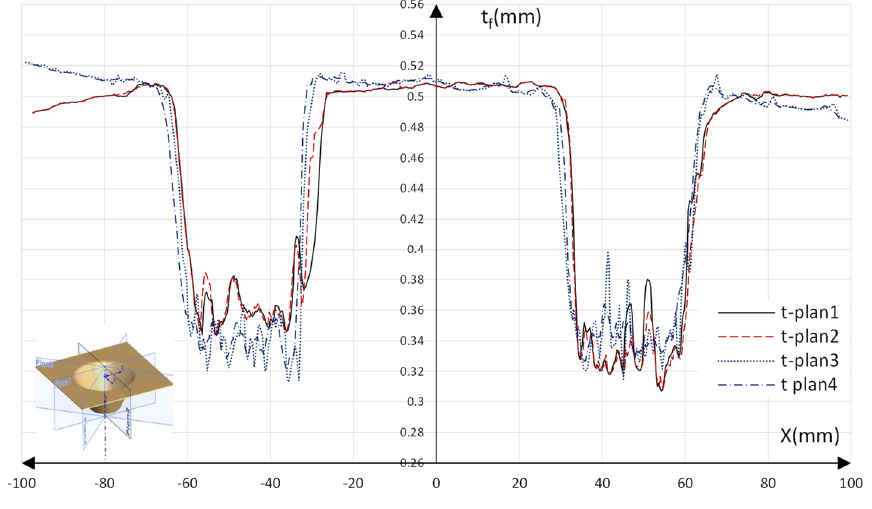
Figure 9. Experimental thicknesses (tf) according to the four cutting planes for h = 40 mm. Experimental profile shapes according to the four cutting planes (U plane1 , U plane2 , U plane3 , U plane4 ) are given in Figure 10, and relative errors of the profiles’ shapes compared to the profile of plane 1 (U plane1 ) are shown in Figure 11. It is clearly observed that errors are always small and do not exceed 3%. As shown in Figure 11, the error is significant at the tips of the cone entrance leaves called zone 1. This error decreases in zone 2 and then increases to cancel in the center of the bottom of the cone zone 3. Many of these errors are related to the palpation of the Coordinate-Measuring Machine.